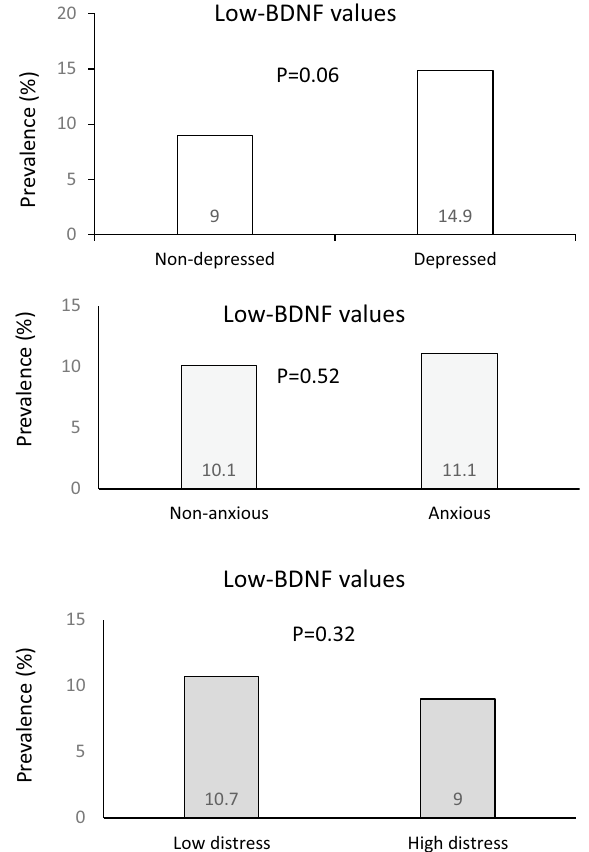
Figure 4. Prevalence of low-BDNF values in participants with psychological disorders compared to healthy